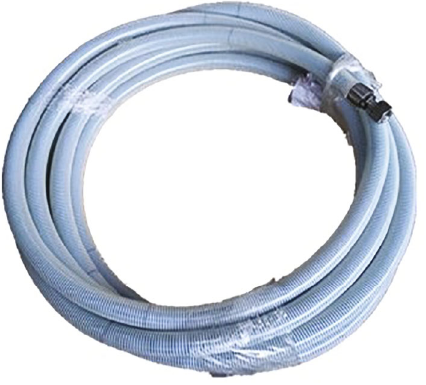
Figure 14: Schematic diagram of high-voltage remote console.